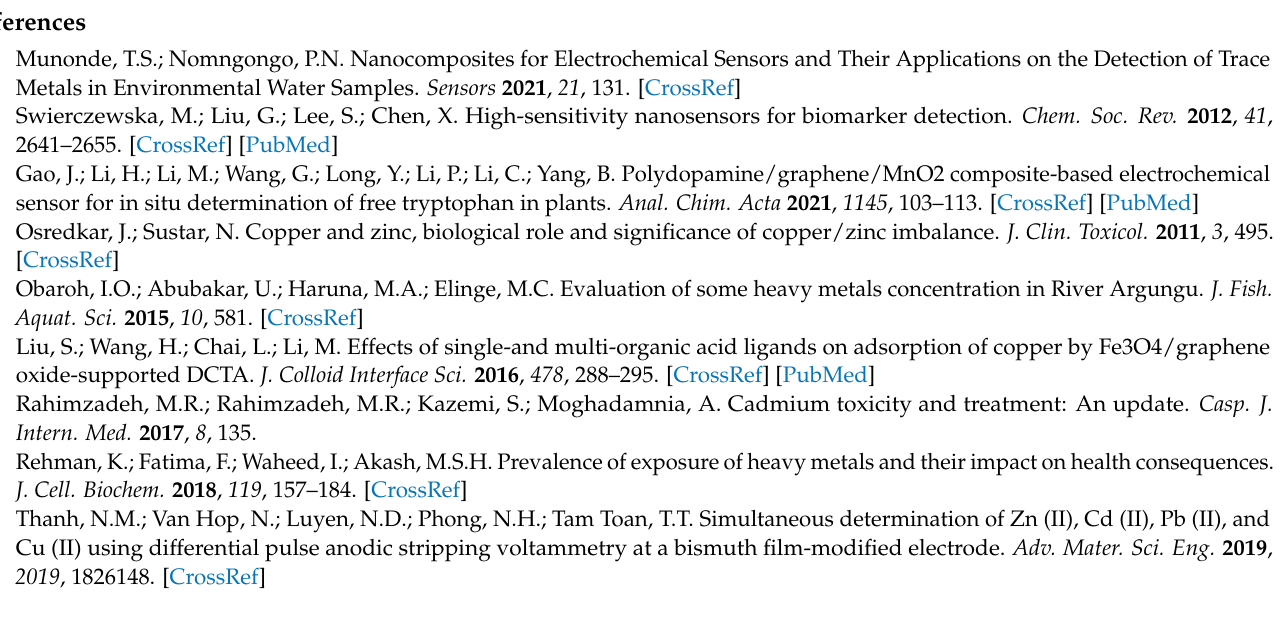
Figure S9: Profiles for predicted values and desirability of Cu(II) Table S1 Design of experiments